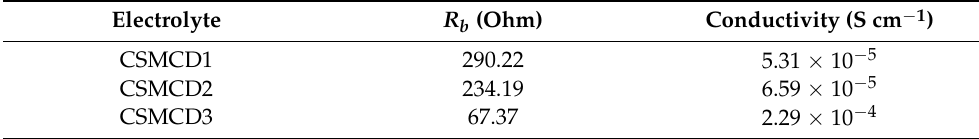
Table 1. The R b and conductivity values of the electrolytes.